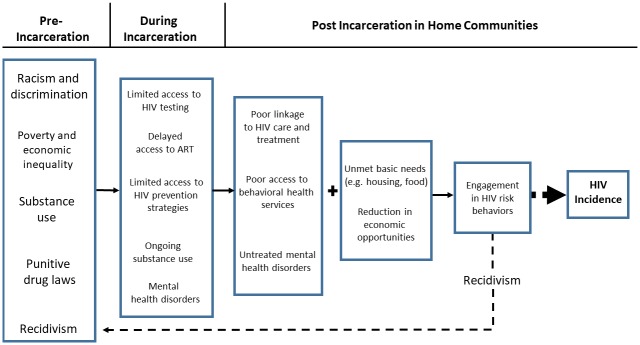
Drivers of onward HIV transmission from pre-incarceration to release in home communities.